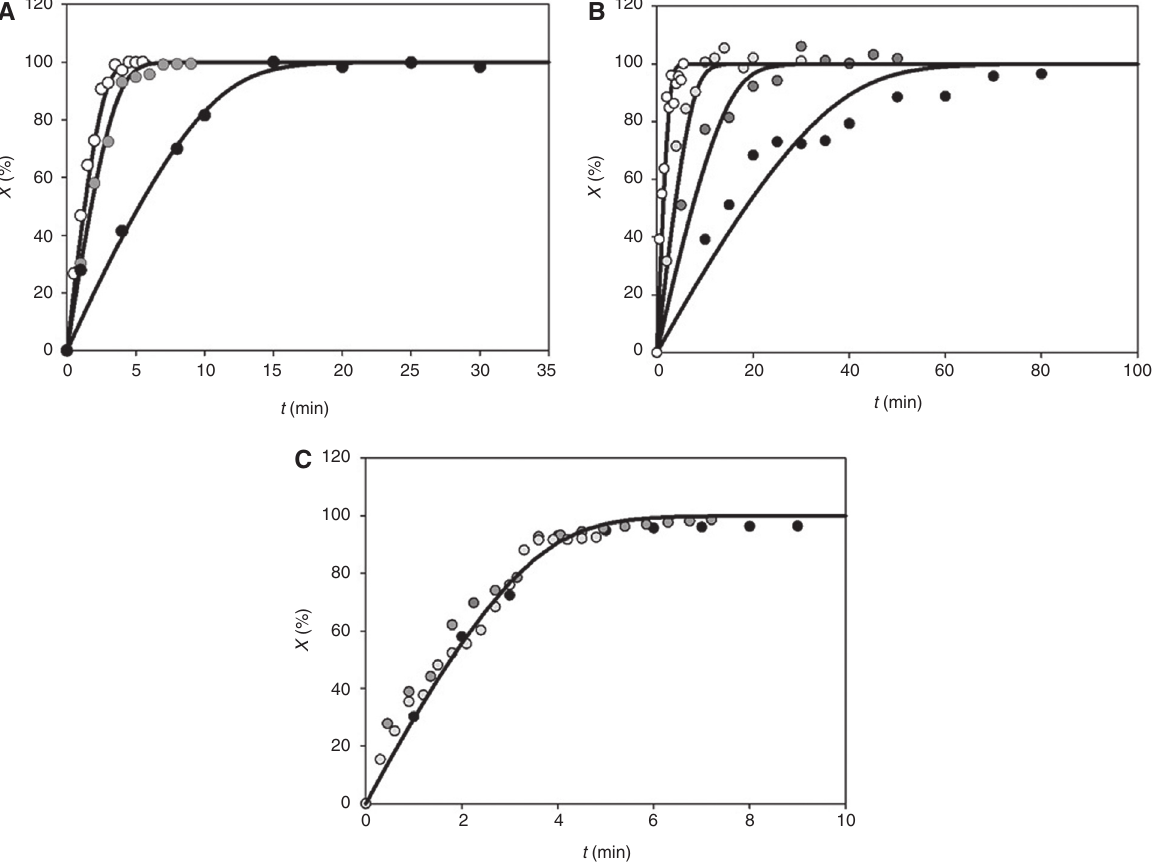
Figure 2 NADH coenzyme regeneration in a batch reactor (A) influence of enzyme activity (○ 118 ± 6 U/mg, ● 65 ± 2 U/mg, ●19 ± 3 U/mg) (B) influence of nanoparticle amount (○ 5 mg, ● 2.5 mg, ● 1.25 mg, ● 0.5 mg, S.A . = 118 ± 6 U/mg) (C) influence of storage time (● 0 h, ● 96 h, = 40 mmol/dm 3 , c = 5,5 mmol/dm 3 , — ● 264 h) ( T = 25 ° C, c i,acetaldehyde i,NADH